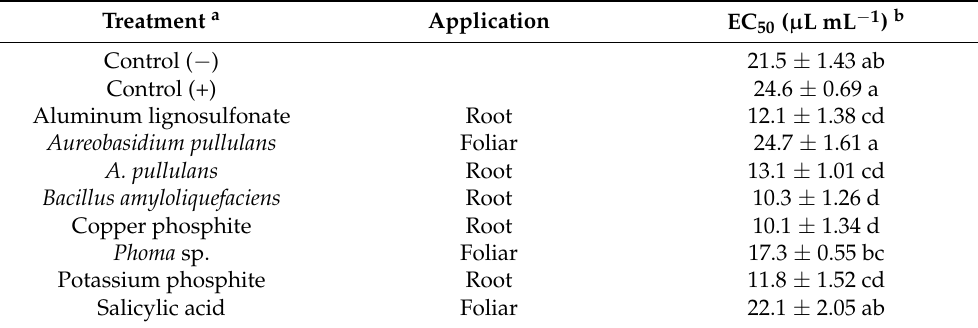
Table 2. Effective concentrations of olive stem extract (OSE) from cv. Picual treated with several compounds to inhibit 50% of conidial germination (EC 50; µ L mL − 1 ) of Verticillium dahliae isolate